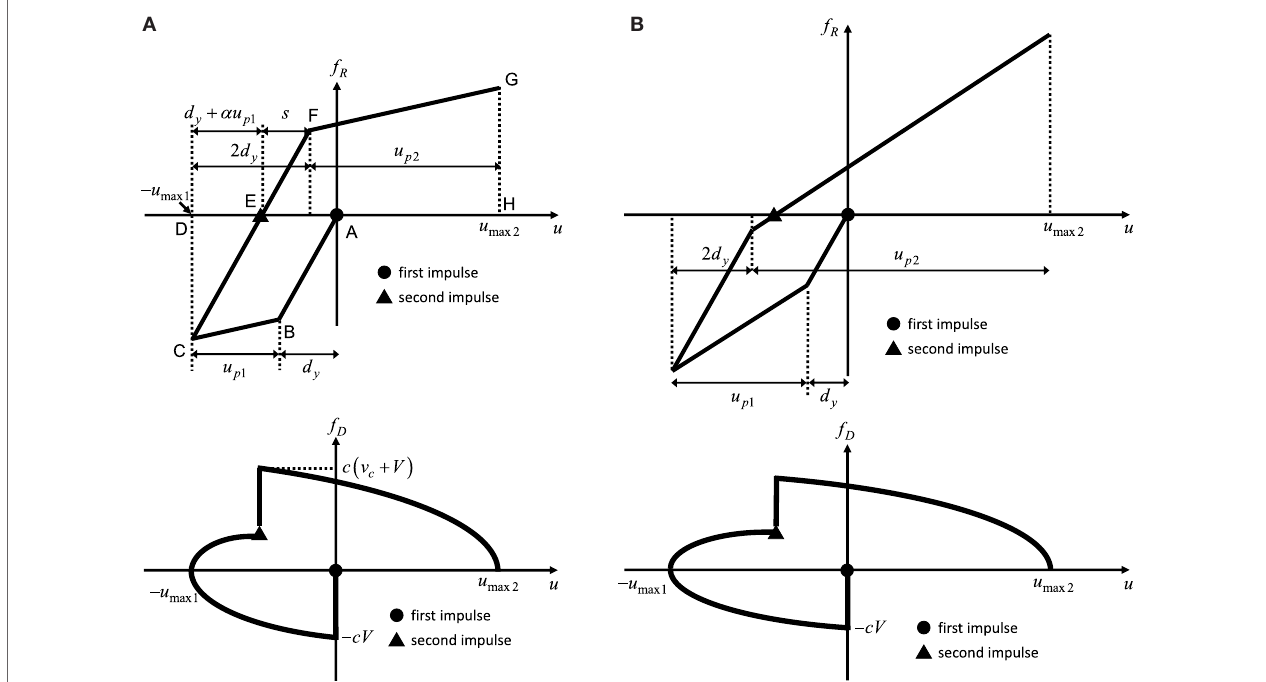
FIGURE 6 | Restoring force–deformation relation and approximate damping force–deformation relation. (A) CASE 3-1: ( V / V y ) CASE2 (cid:20) V / V y (cid:20) ( V / V y ) CASE3 , (B) CASE 3-2: ( V / V y ) CASE3 (cid:20) V / V y .